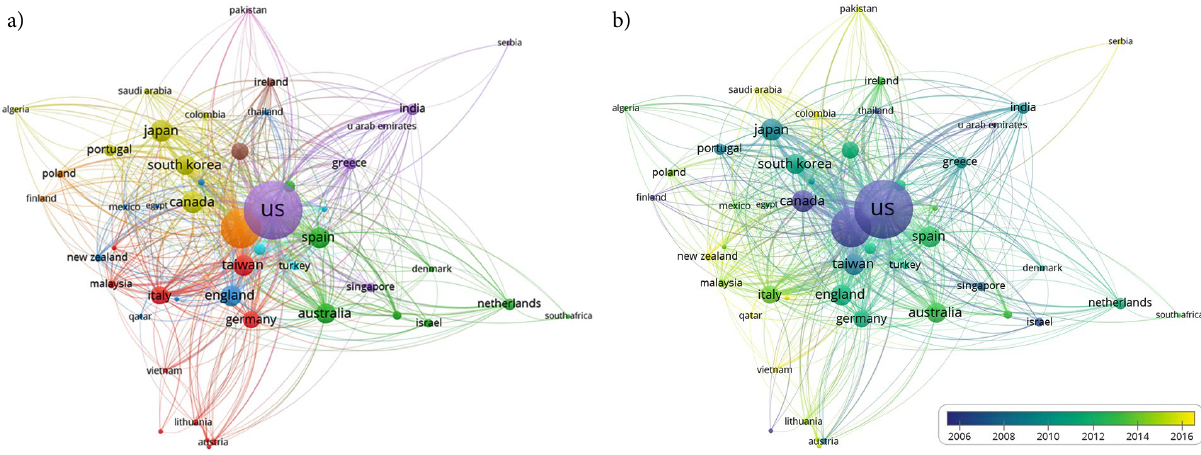
Figure 6. The citation analysis of countries/regions published documents in the CACAIE: a – the citation network; b – the time overlay network